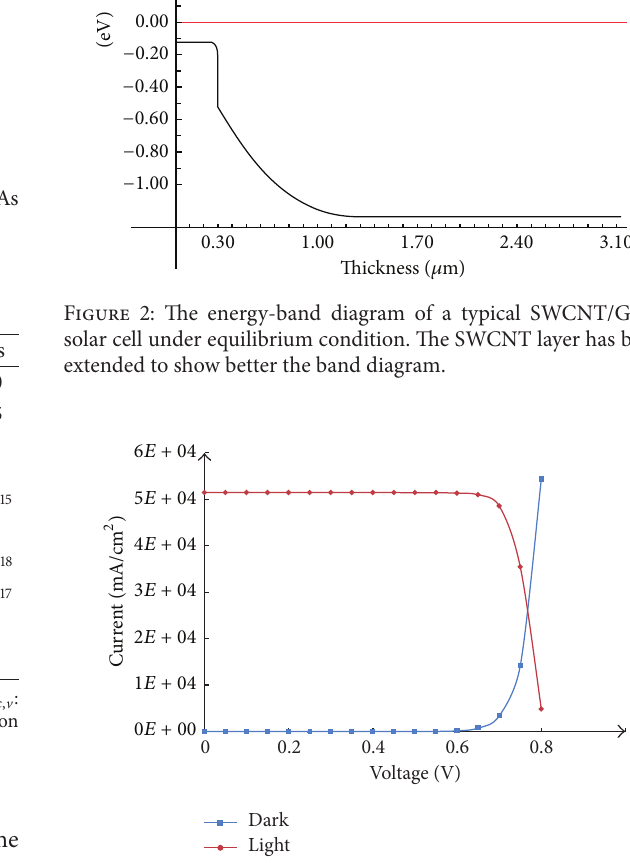
Figure 3: The current-voltage characteristics calculated by AMPS in dark and under 1 sun standard